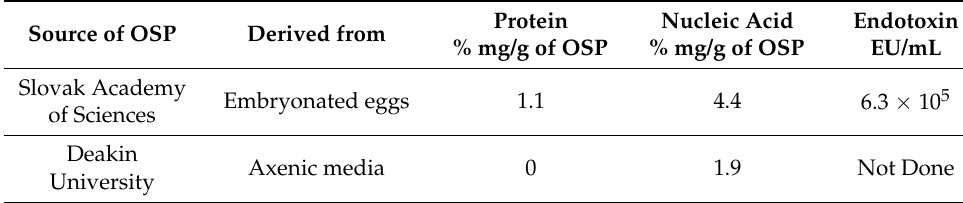
Table 1. Analysis of OSP derived from different sources. Source of OSP Derived from